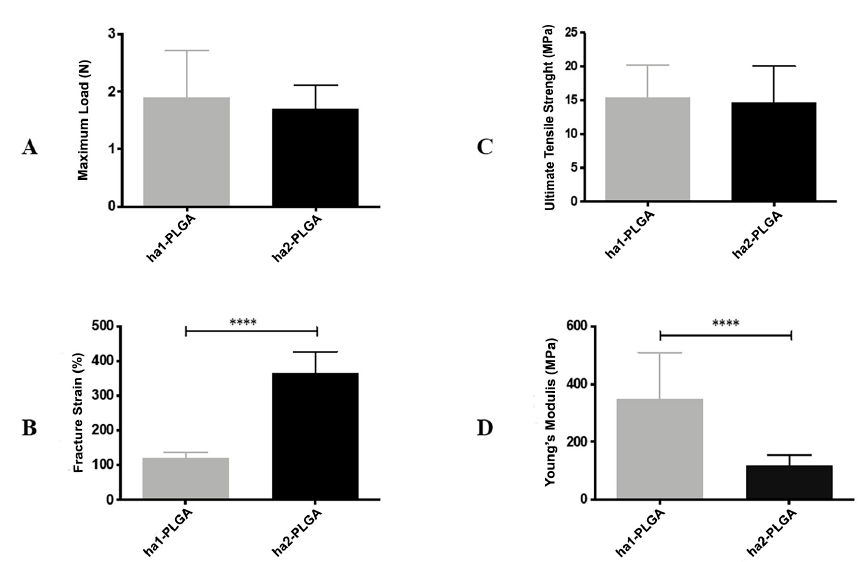
Figure 4. Mechanical characteristics of ha1- and ha2-PLGA fleeces. ( A ) Maximum Load (N); ( B ) Fracture Strain (%); ( C ) Ultimate Tensile Strength (MPa); ( D ) Young’s Modulus (MPa) carried out on ha1-PLGA and ha2-PLGA fleeces (n = 5 for each type of fleece, fleece dimension: 50 mm × 15 mm). Electrospun ha2-PLGA fleeces possess higher Fracture Strain values compared to those for ha1-PLGA, whereas ha1-PLGA fleeces possess higher Young’s Modulus values compared to those for ha2-PLGA.